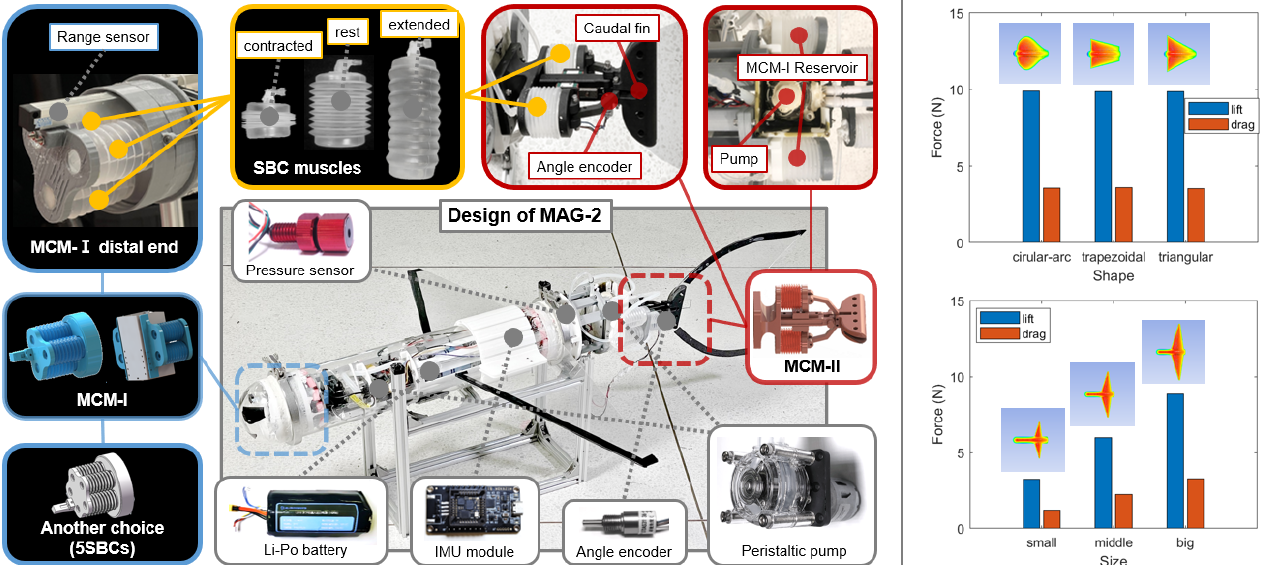
Figure 3. ( Left ) Design of the proposed MAG-2, with system components and details of the MCM- I and MCM-II mechanisms. ( Right ) Simulation results of wings of different shapes, but the same size. Simulation results of wings of different sizes, but with the same shape.